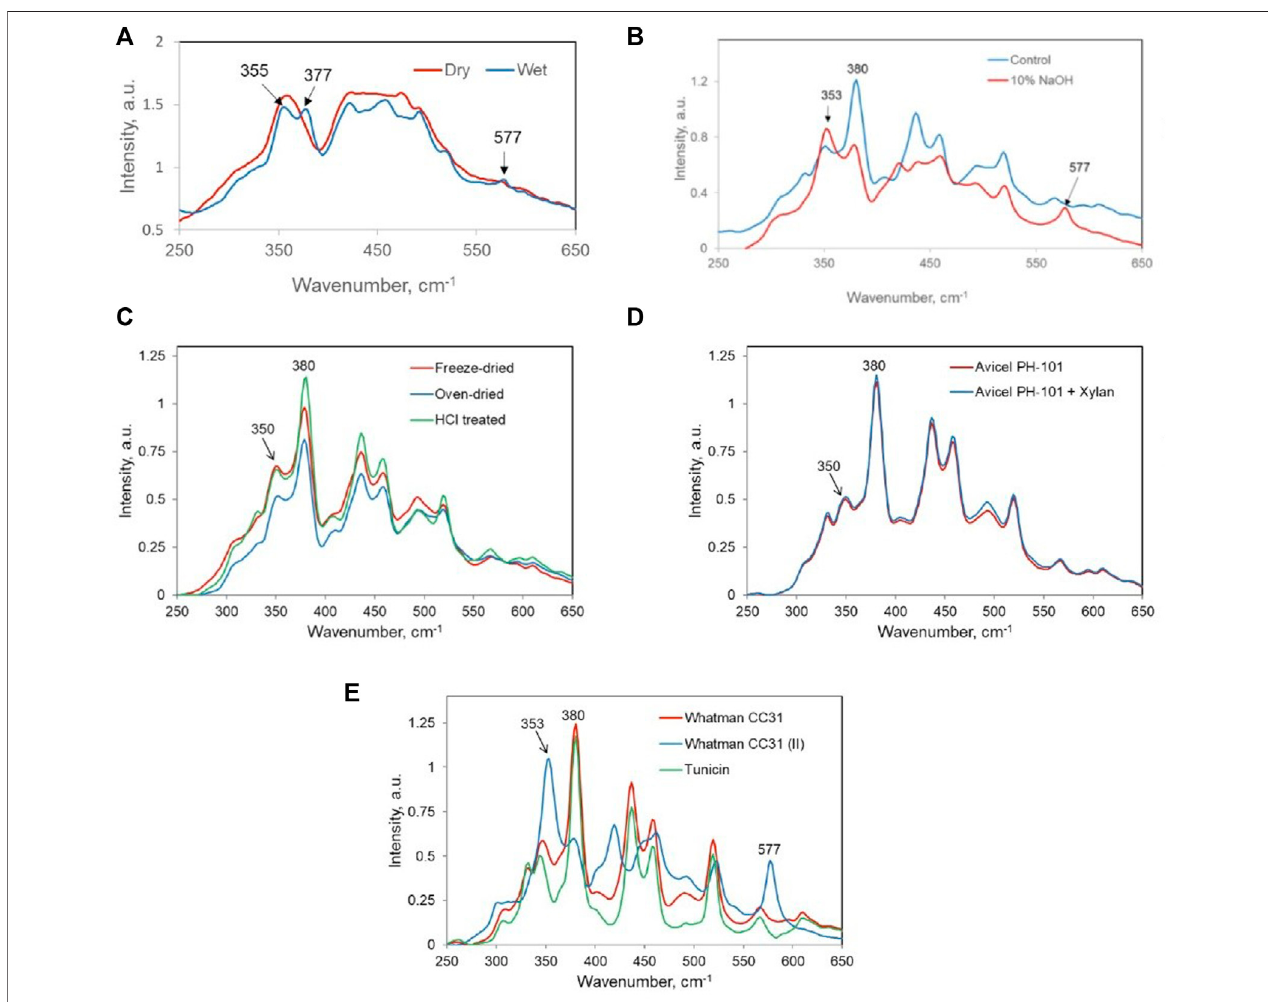
FIGURE 5 | Raman spectra of (A) dry amorphous and wet amorphous celluloses; (B) control and 10% NaOH-treated softwood bleached kraft pulp; (C) NaOH- treated aspen holopulp — freeze-dried, oven-dried, and HCl-treated (#5, #6, and #7, Table 4 ); (D) Avicel PH-101 and 10% xylan containing Avicel PH-101 (samples #8 and #9, Table 4 ); (E) Whatman CC31, Whatman CC31 (Cellulose II), and tunicin (#10 – #12, respectively; Table 4 ).